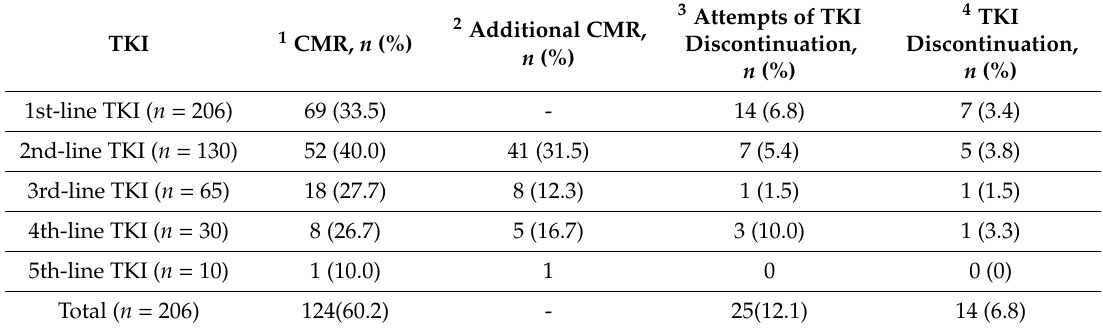
Table 3. Percentages of complete molecular response and TKI discontinuation at each treatment line. TKI 1 CMR, n (%)